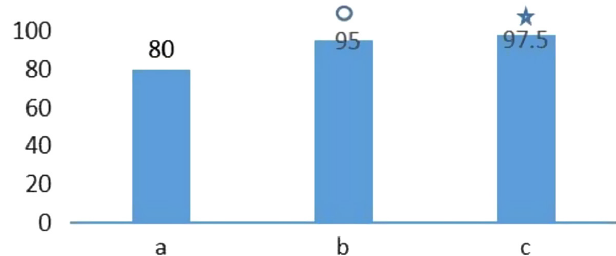
Figure 1. Comparison of the H. pylori eradication rate of the 3 groups. (A) Traditional quadruple therapy group; (B) vonoprazan triple therapy group; (C) vonoprazan quadruple therapy group.